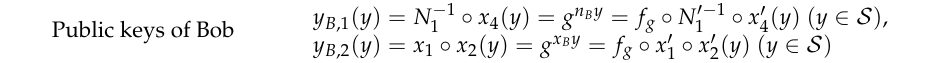
Table 5. Public keys of Bob for C NDH . Public keys of